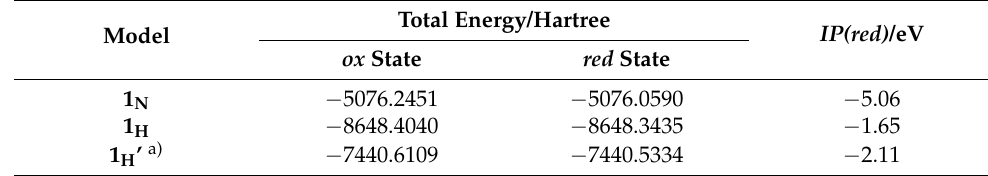
Table 3. Calculated total energies of the ox and red states, and IP(red) values for models 1 H and 1 N . Total Model